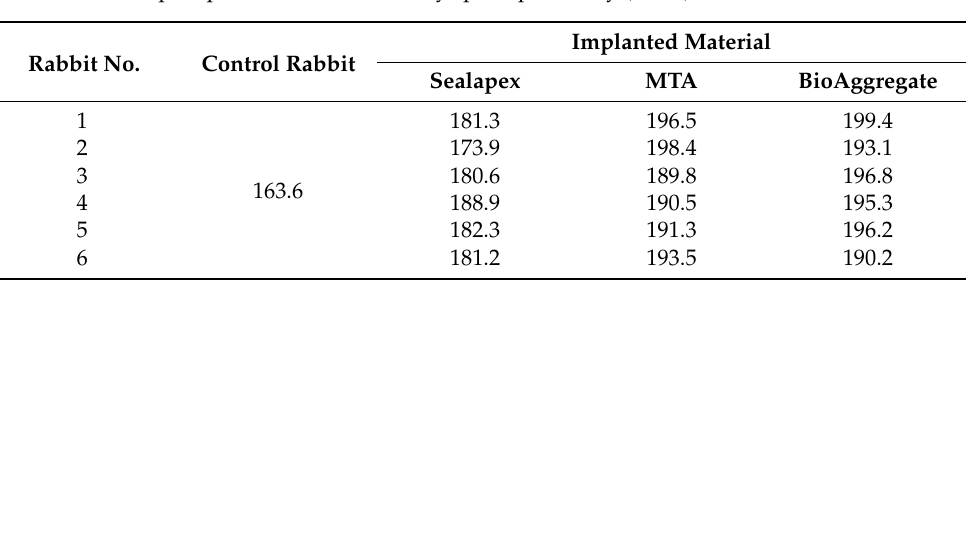
Table 1. Alkaline phosphatase values at 7 days postoperatively (IU/L). Rabbit No.